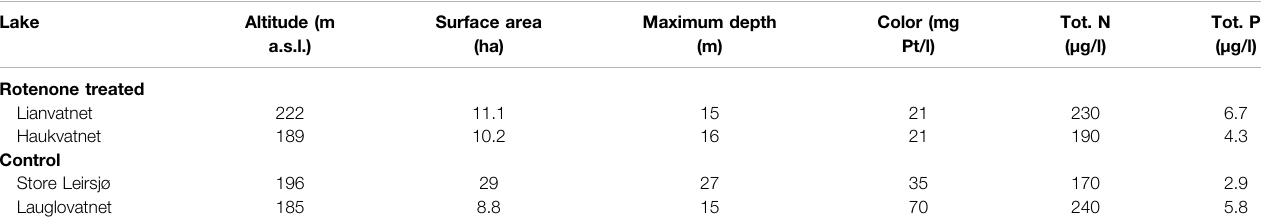
TABLE 1 | Abiotic characteristics of the study lakes. Water quality parameters were sampled in July 2019. Lake Altitude (m